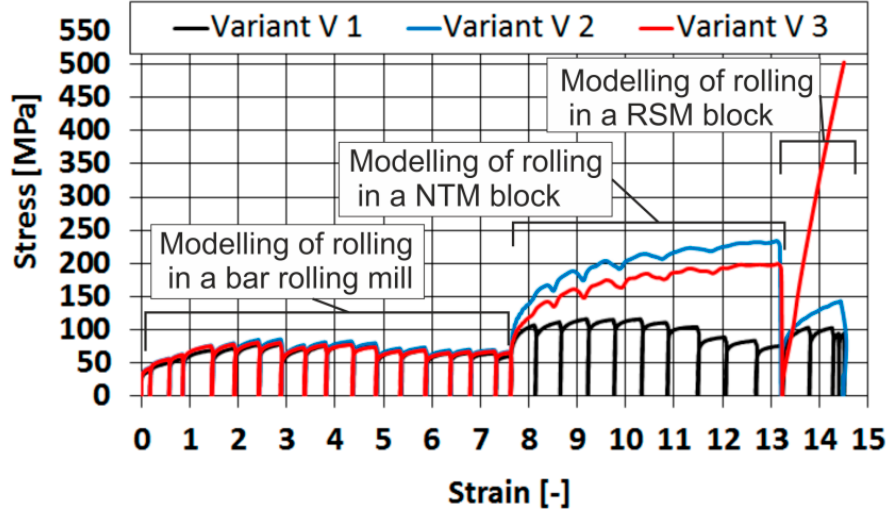
Figure 12. General course of yield stress during physical modelling of rolling a 20MnB4 steel wire rod with a diameter of 5.5 mm (test variant V1, test variant V2, test variant V3.